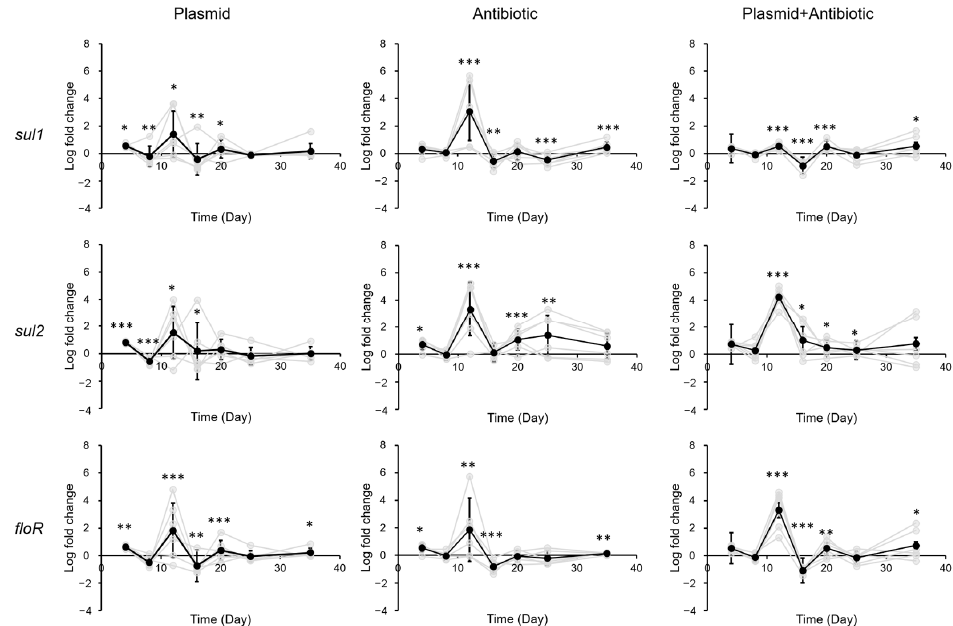
Figure 5. Change in ARG levels in mouse large intestine after exposure to pR55 (plasmid), sulfadi- azine (antibiotic), or pR55 + sulfadiazine (plasmid + antibiotic). Each gray line indicates a mouse group (male groups 1–3, female groups 1–3). Black line indicates average of all six groups. Error bars indi- cate standard deviation of 6 replicates (3 males and 3 females). *, p < 0.05; **, p < 0.01; ***, p < 0.001.